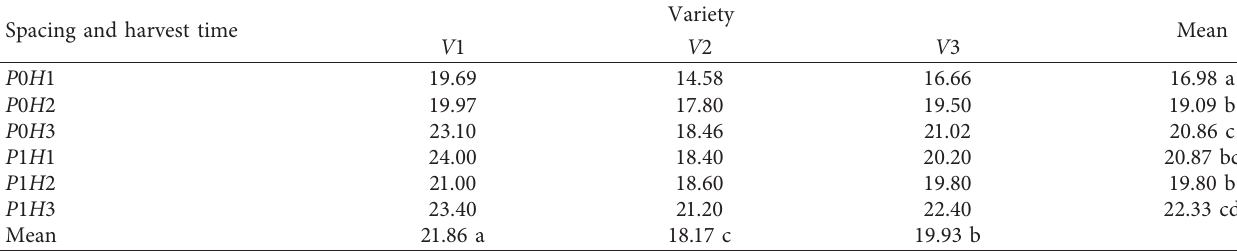
Table 7: Cob weights (ton/ha) of sweet corn of different varieties and at different harvest times. Spacing and harvest time